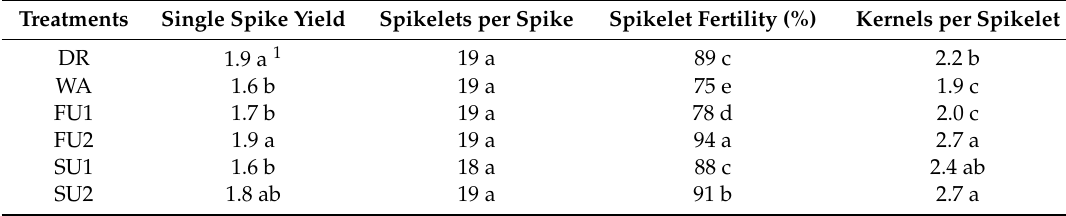
Table 2. E ff ects of urea applied after waterlogging on single spike yield, spikelets per spike, fertile spikelet, and kernels per spikelet. Treatments Single Spike Yield Spikelets per Spike Spikelet Fertility (%) Kernels per Spikelet DR 1.9 a 1 19 a 89 c 2.2